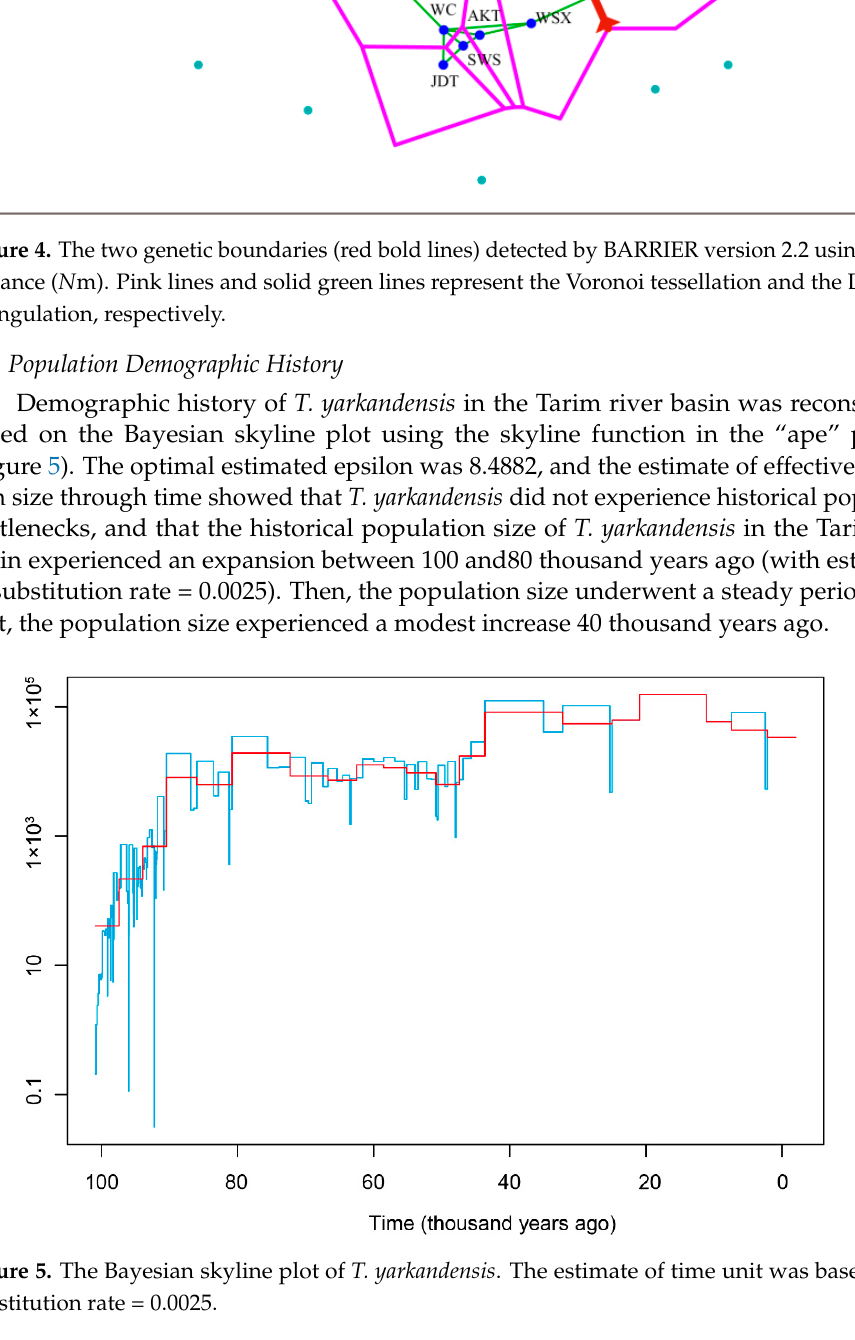
Figure 5. The Bayesian skyline plot of T. yarkandensis. The estimate of time unit was based on the substitution rate = substitution rate = 0.0025.